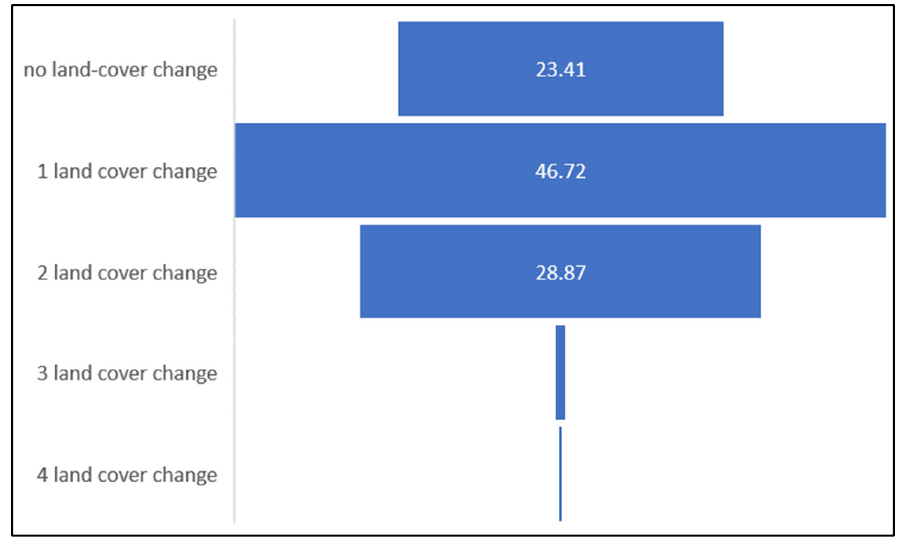
Figure 6. Percentage change of land-cover change-frequency distribution between 1995 and 2018.